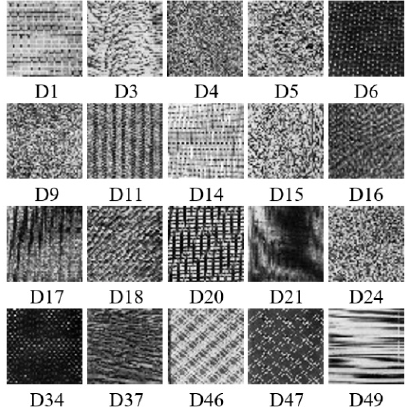
Figure 13. Instances samples of DS-Broadtz dataset.